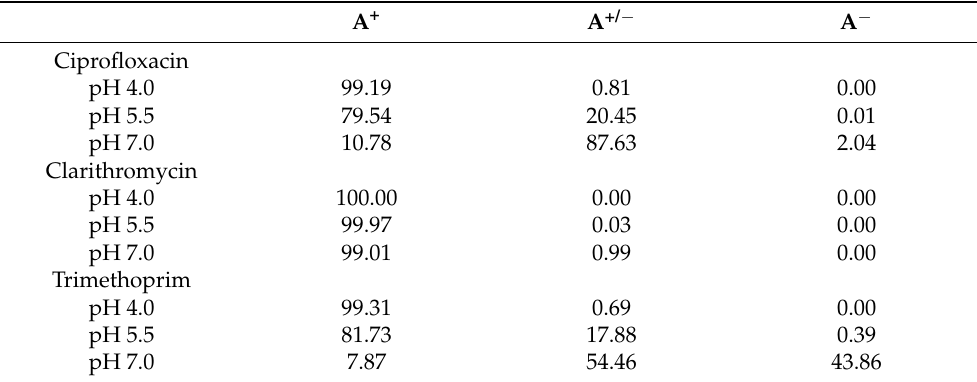
Table 3. Percentages of different species of antibiotics as a function of pH. A: Antibiotic. A